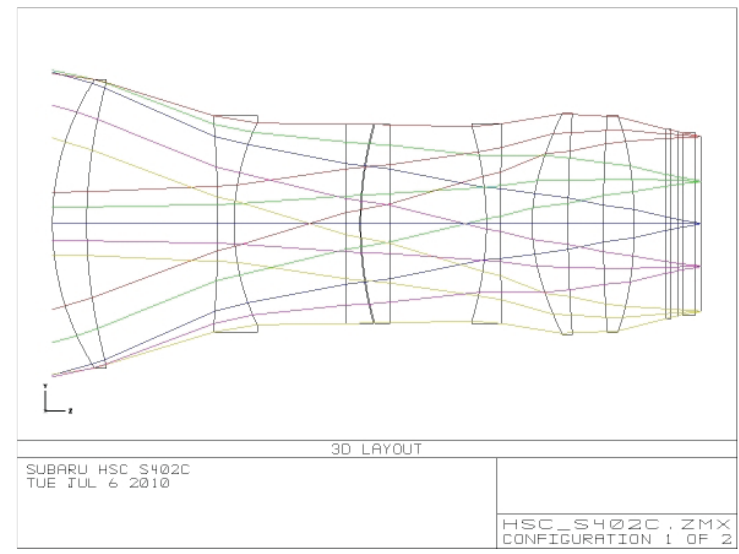
Figure 4. Optical design scheme of HSC [18].